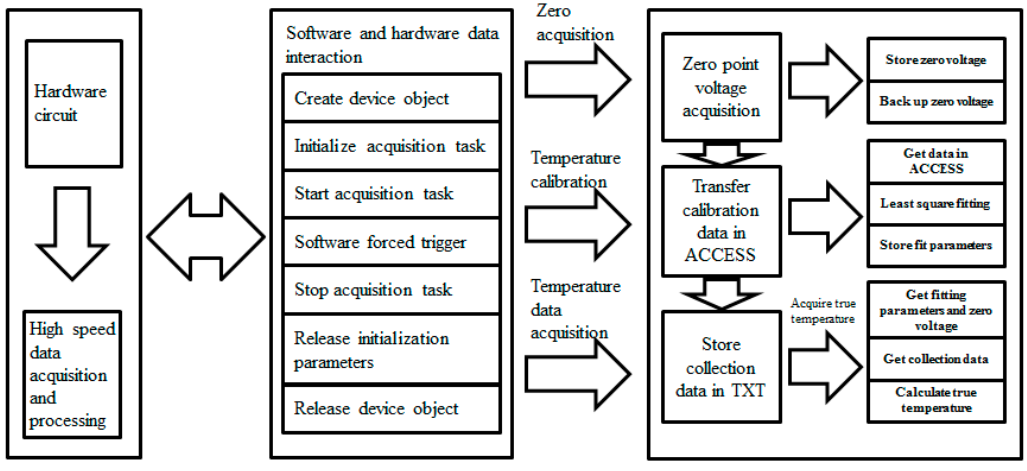
Figure 11. A flow chart of the software part.